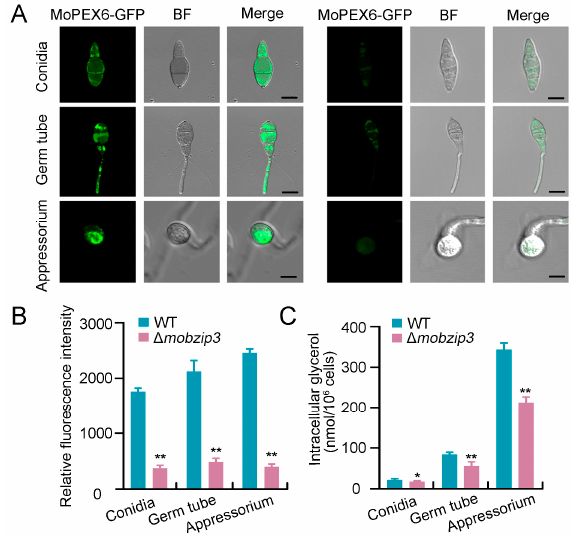
Figure 6. MoBZIP3 affects glycerol accumulation in appressorium. ( A ), Expression of MoPEX6 in ∆ mobzip3 . MoPEX6 -GFP driven by its native promoter was expressed in WT and ∆ mobzip3 . GFP fluorescence were observed under fluorescence microscopy in the M. oryzae conidia, germ tube and appressorium. Bar = 10 µ m. ( B ), Quantification of GFP fluorescence in ( A ). Error bars represent SD, n ≥ 50 cells, ** p < 0.01. ( C ), Quantification of glycerol in WT and Δ mobzip3 . Error bars represent ±SE of three biological replicates and asterisks represent significant differences (* p < 0.05 and ** p < 0.01).